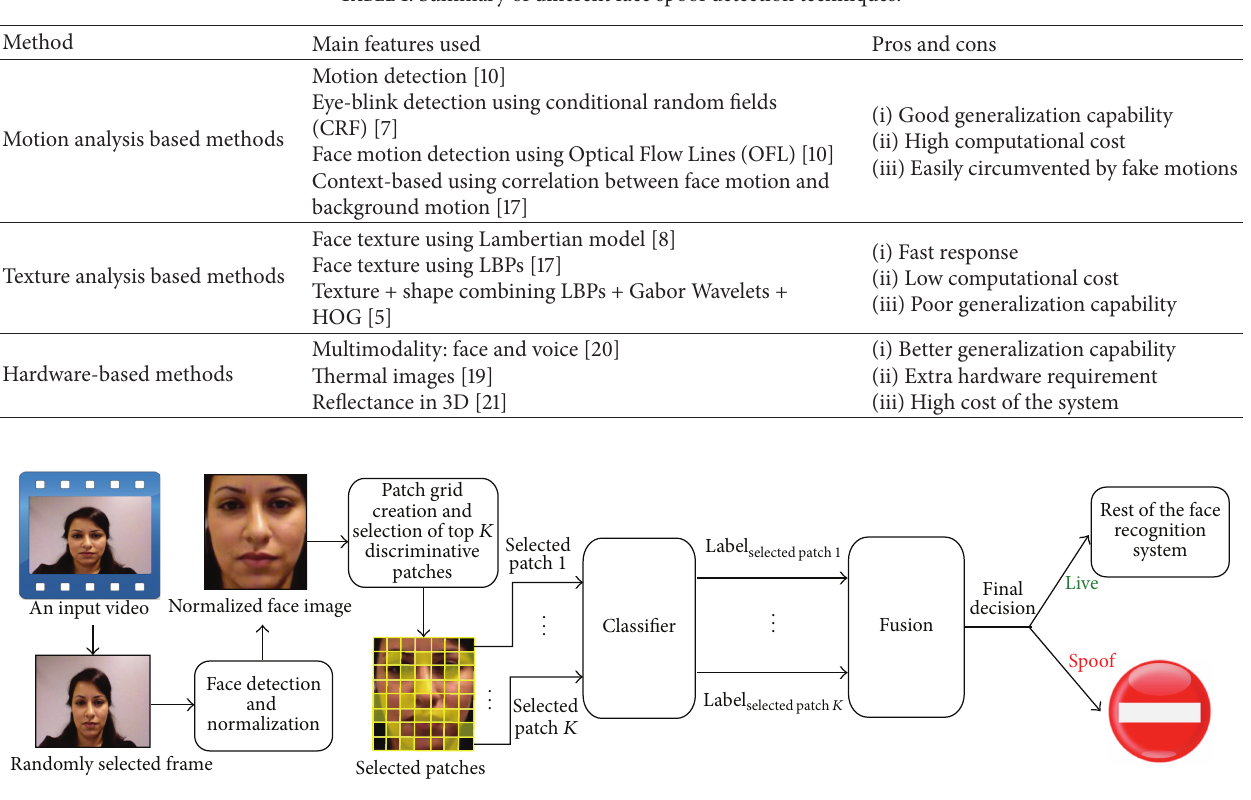
Table 1: Summary of different face spoof detection techniques.